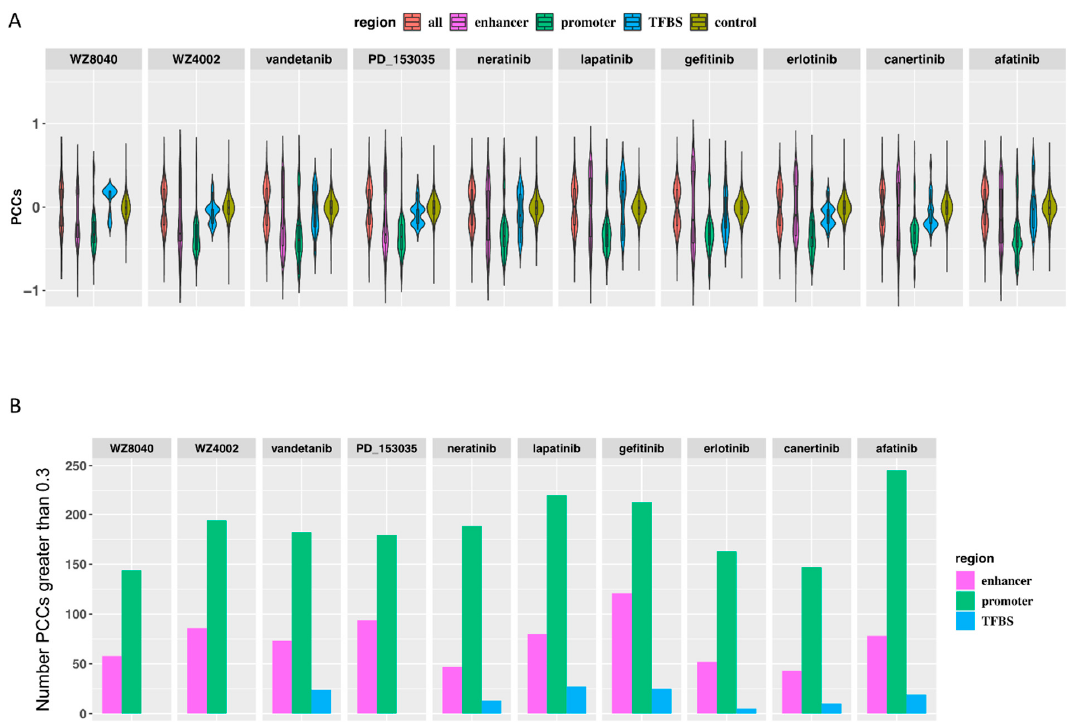
Figure 5. Spearman correlation coefficients between the predicted EGFR inhibitor-responsive genes and the associated methylation sites. ( A ) According to the location information of methylation sites, they were divided into five groups, namely, the enhancer group, the promoter group, and the TF binding group, which were located in the three regulatory groups and the control group. ( B ) The barplot shows the number of PCCs related to enhancer, promoter, and TF binding regions greater than 0.3.